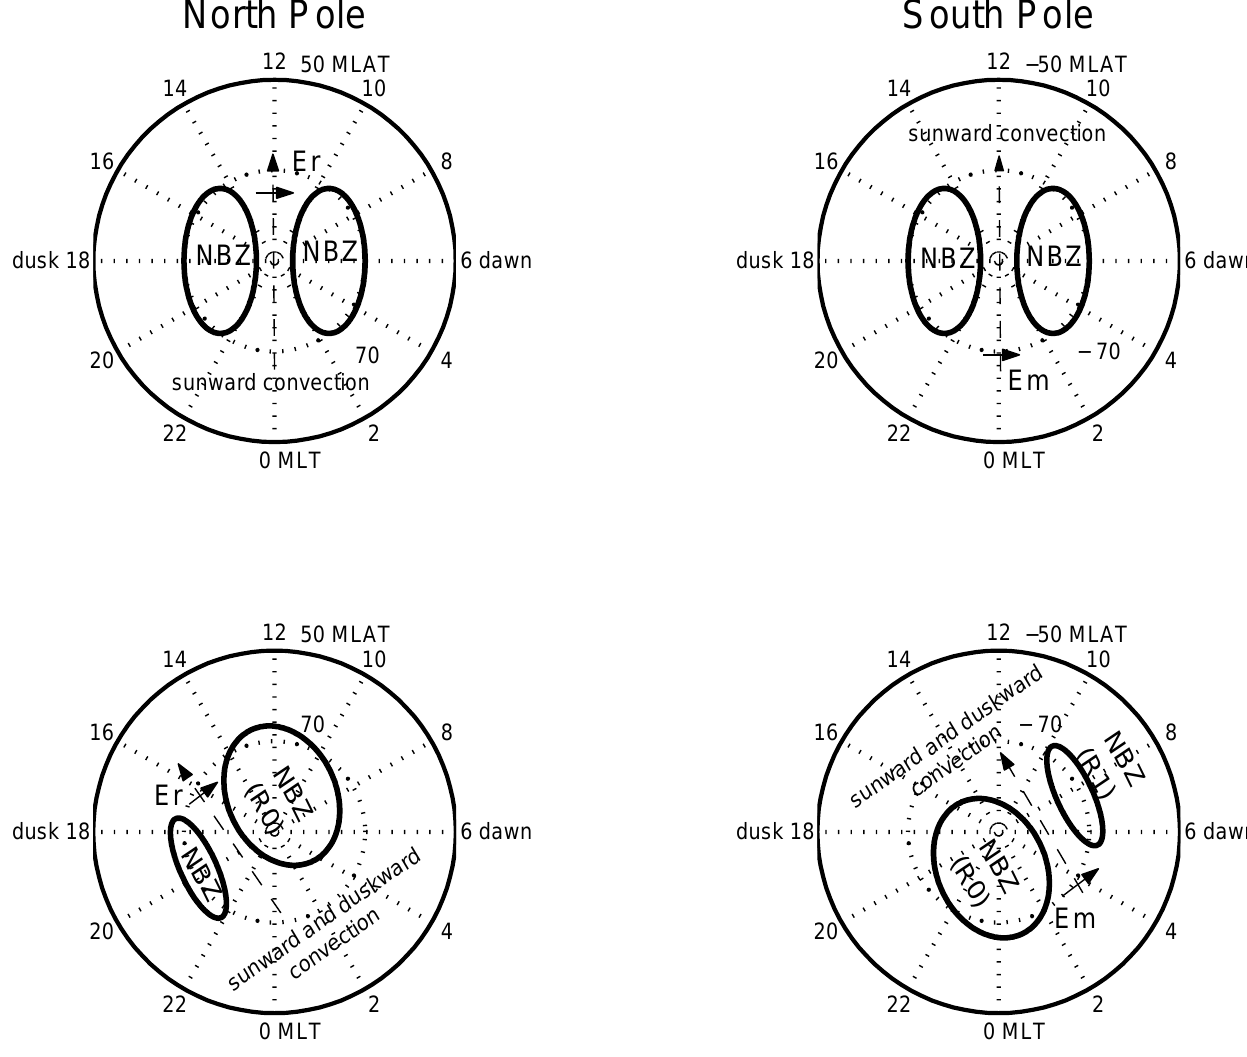
Fig. 11. NBZ FACs, convection velocity associated with the mapped merging ( Em ) and reconnected electric field ( Er ). The top two panels are for purely northward IMF, and the bottom two panels are for northward and duskward IMF. The left column is in the Northern Hemisphere and the right is in the Southern Hemisphere. The two blue ovals mark the area of NBZ FACs. The dashed arrow line denotes the convection velocity and the real arrow line denotes the merging and reconnection electric field.